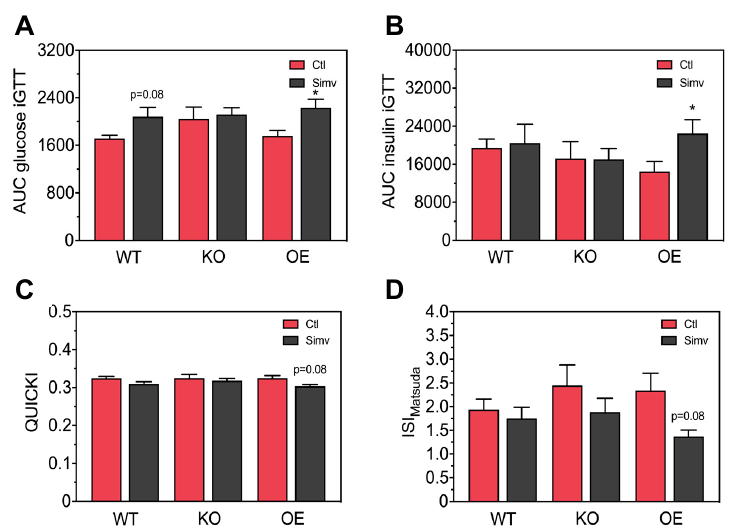
Figure 3. Area under the curves for the glucose blood and insulin plasma concentrations during the intraperitoneal glucose tolerance test, and insulin sensitivity indexes. Blood glucose concentrations ( A ) and insulin plasma concentrations ( B ), measured during the glucose tolerance test, were quantified as the area under the curve using the trapezoid method. Surrogate indexes for insulin sensitivity were calculated as the QUICKI ( C ) and the insulin sensitivity index by Matsuda ( D ). After two-way ANOVA analysis, the treatment factor was significant in ( A , B , D ) and there was no significant effect of the animal models and no significant interaction. Data are presented as mean ± SEM of 10 animals per group. * p < 0.05 between simvastatin-treated and respective control mice. Ctl, control; KO, PGC-1 α knock-out mice; OE, PGC-1 α overexpressing mice; Simv, simvastatin; WT, wild- type.